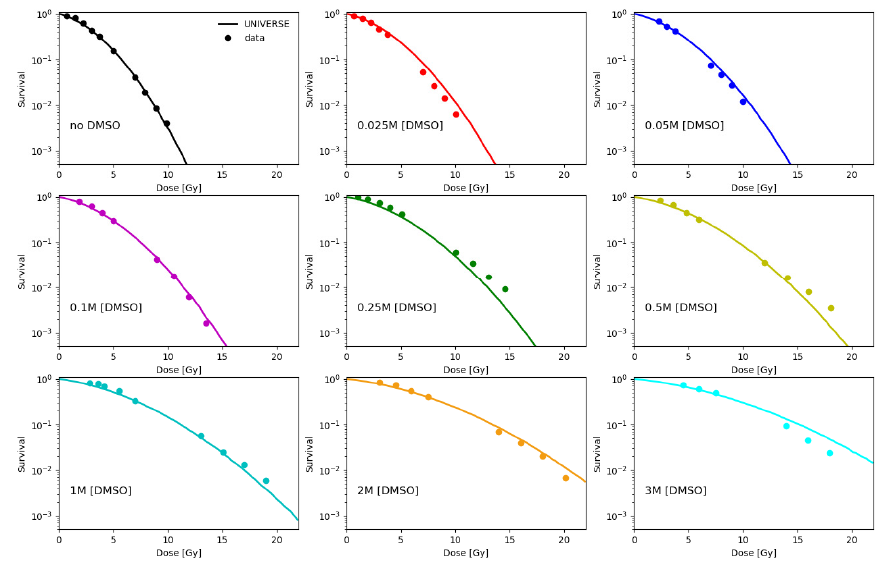
Figure 2. Model predictions (lines) based on the parametrization found in Figure 1 (lines) are plotted together with cell survival data (dots) of V79 cell line irradiated under normoxia without and with different DMSO concentrations ranging from 0.025 M to 3 M, taken from Chapman et al. [16].